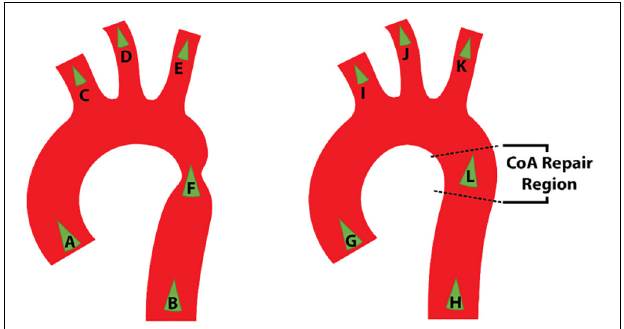
FIGURE 1 | Schematic representation of the location of Doppler transthoracic echocardiographic measurement sites before (left) and after (right)